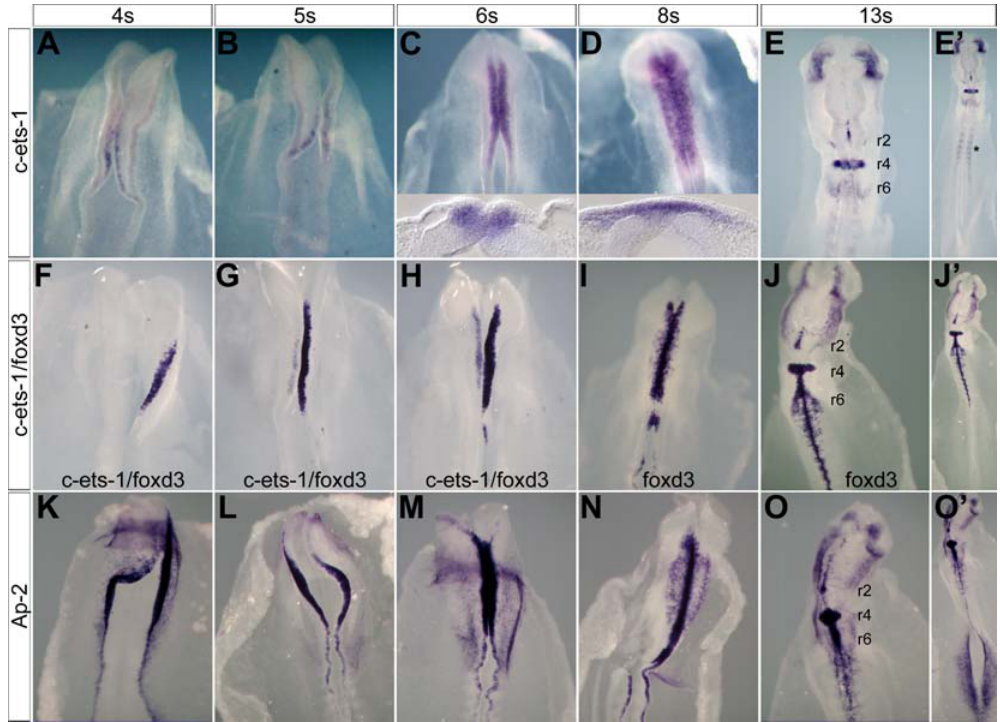
Figure 2. Ets-1Expression Occurs Later and in a More Restricted Area than Those of Foxd3 and AP2. (A–O’) Whole in situ hybridization of normal chick embryos at stages 4s–13s using c-ets-1 (A–H), foxd-3 (F–J’) and ap-2 (K–O’) probes. (F–H) Embryos were cut along the rostro-caudal axis. The left and right sides of the neural tube were treated independently with c-ets-1 and foxd-3 probes. C-ets-1 expression (A–B, F–G) begins after foxd-3 (F–G) and ap-2 (K–L) expressions. It is restricted to cells leaving the neural tube (C–D, insets) and cranial region (compare E–E’ to J–J’ and O–O’). * indicates ets-1 expression in the sclerotome. r, rhombomere.